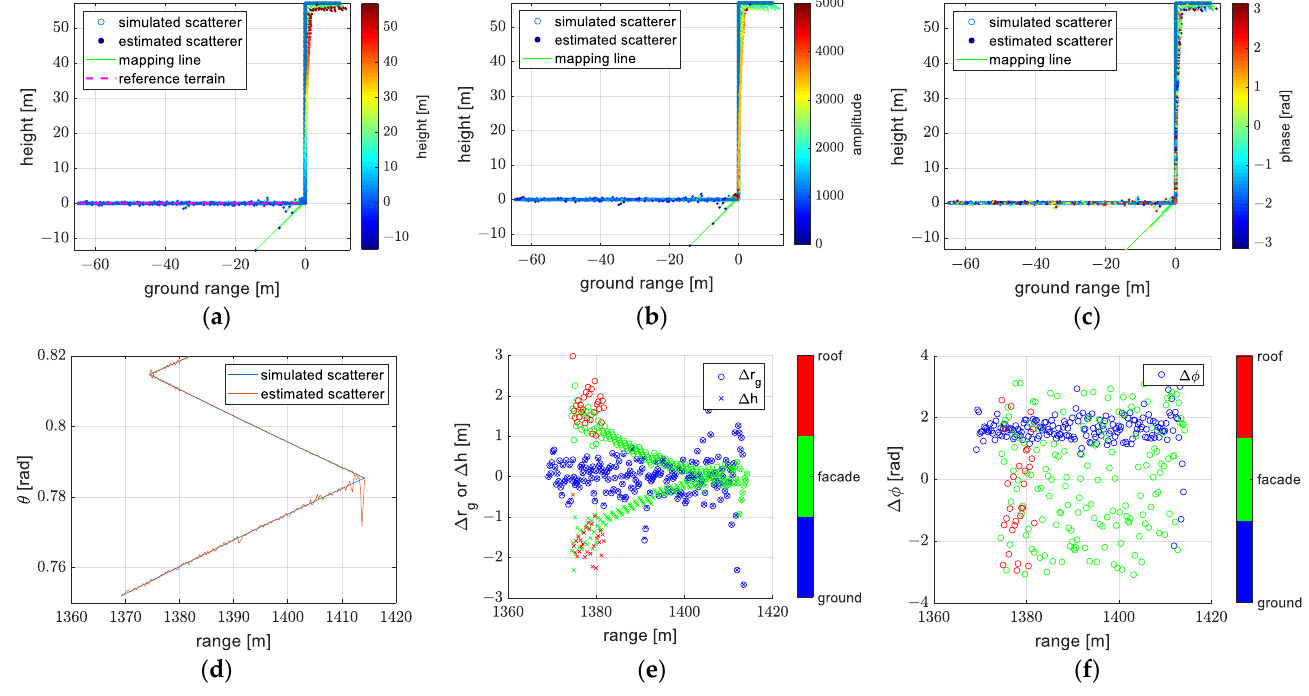
Figure 18. The reconstruction obtained under model 1 (the exact form of the planar wavefront model) in experiment 2: ( a ) reconstruction with colors denoted as height, ( b ) reconstruction with colors denoted as amplitude, ( c ) reconstruction with colors denoted as phase, ( d ) the off-nadir angle of the reconstruction, ( e ) the error of the ground range and height, ( f ) the error of the phase. Although the reconstruction is not perfect like Figure 16, the effectivity of the transfor- mation between model 1 and model 5 in a complex scenario can still be